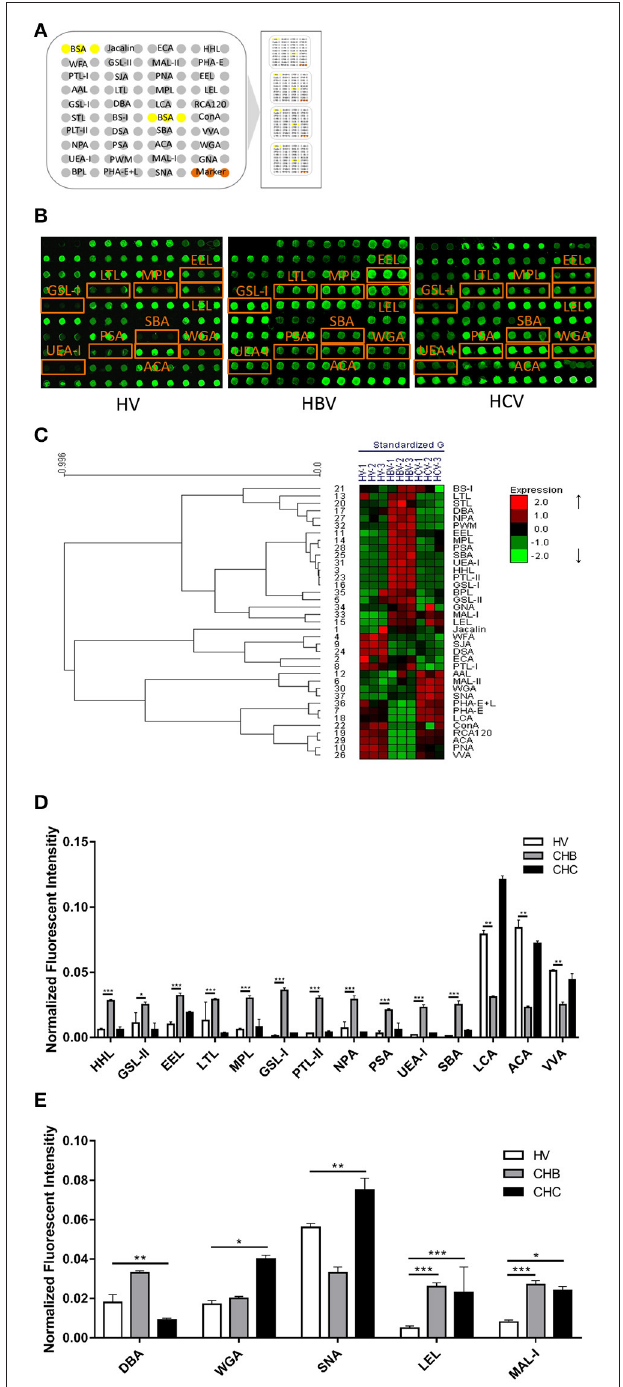
FIGURE 1 | The glycopatterns of pooled sera glycoproteins from HV, CHB, and CHC patients using a lectin microarray. (A) The layout of the four area lectin microarray. Each lectin was spotted in triplicate per block, with quadruplicate blocks on one slide. Cy3-labeled BSA was spotted as a location marker and BSA as a negative control. (B) The profiles of Cy3-labeled pooled sera proteins from HVs and patients with CHB and CHC bound to the lectin microarrays. A portion of the slide with four replicates of the lectin microarrays